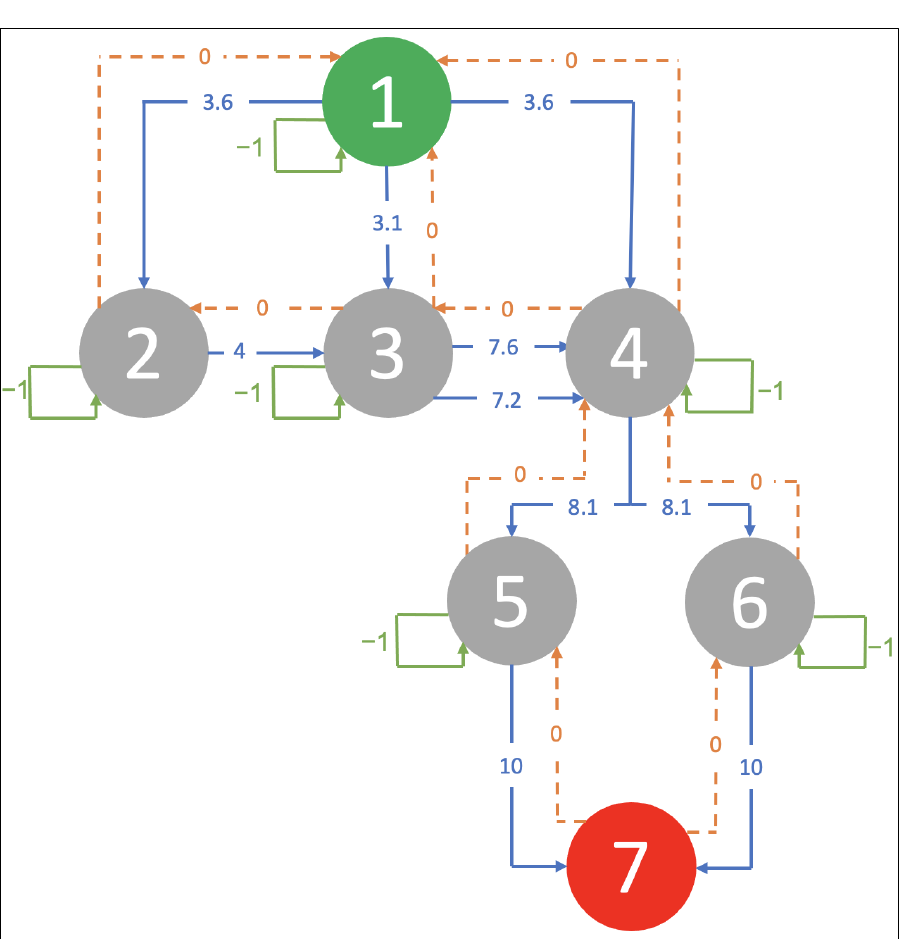
Figure 3. Refinement graph with nodes from 1–7 representing systems’ states as given in attack graph.